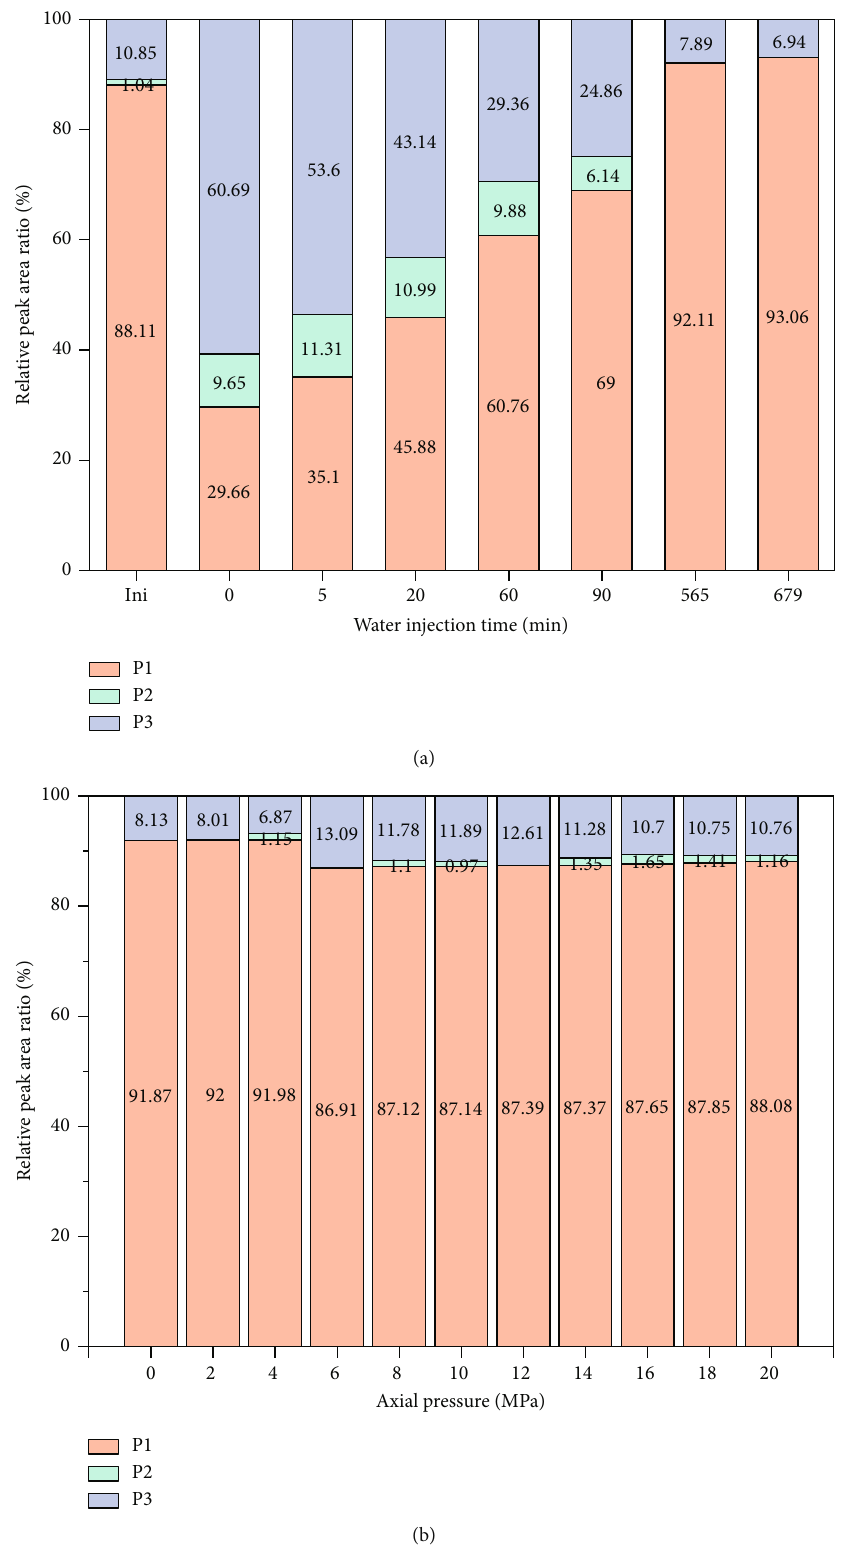
Figure 9: The changes of the relative peak area ratio. (a) Water injection process. (b) Axial compression